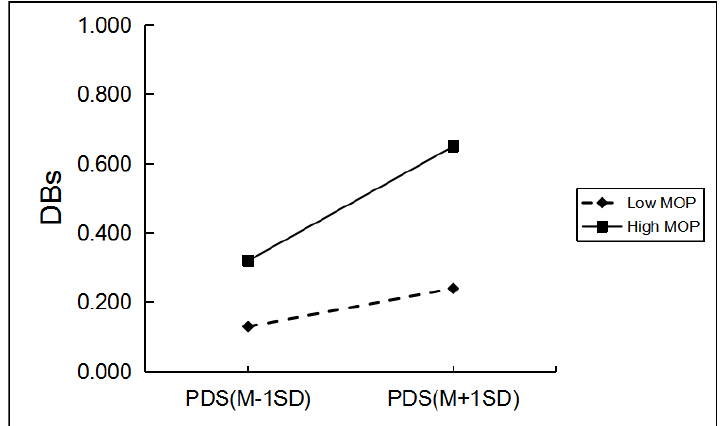
Figure 4. The two- way interaction between PT and MR in predicting girls’ DBs. Note: PDS, the total score of pubertal development scale; MR, mother rejection; DBs, drinking behaviors.